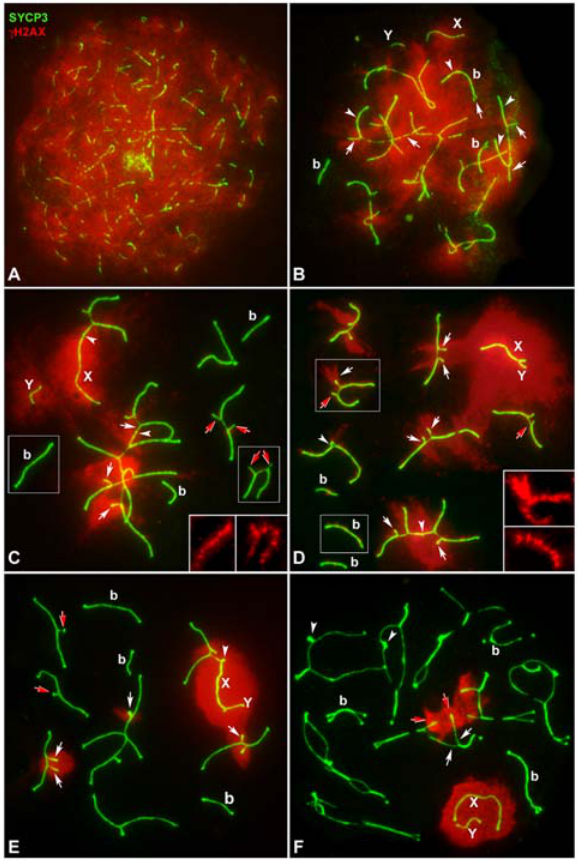
Figure 4. Localization of ATR (green) and SYCP3 (red) during prophase-I. (A) Early zygotene. ATR appears as foci localized in both the unsynapsed AEs (arrows) and the synapsed regions (arrowheads) of all chromosomes, excepting the Y chromosome. (B) Late zygotene. ATR foci are restricted to the AEs of unsynapsed chromosomes (white arrows). However, some unsynapsed AEs do not show ATR signal (red arrows). The Y chromosome (Y) shows a single ATR dot. (b) Bivalents. (C) Early pachytene. ATR appears as an irregular line running all along the unsynapsed AEs of open trivalents (white arrows) and the sex chromosomes (X, Y), although some open trivalents lack labeling (red arrows). Closed trivalents (arrowheads) do not show ATR labeling. (D) Mid-late pachytene. ATR localizes along the AEs of open trivalents (white arrows) and the sex chromosomes (X, Y) and becomes detectable in the surrounding chromatin. A trivalent shows a short unsynapsed AE without ATR signal (red arrow). (E) Late pachytene. ATR is detected along the unsynapsed AEs of trivalents and the sex chromosomes (X, Y) and is intensely distributed in the surrounding chromatin (arrows). (F) Early diplotene. Autosomes begin desynapsis. ATR localizes along the AEs and the surrounding chromatin of two trivalents (arrows) and the sex chromosomes (X, Y). One of the trivalents is ectopically associated with X chromosome (arrowhead). Newly desynapsed autosomes lack ATR labeling (red arrows). progressively faded and completely disappeared by the late diplotene stage. proteins: 1) monoubiquitinated H2A histone (ubiH2A) (Figure 5), known to be associated with transcriptional silencing of un- synapsed autosomes and sex chromosomes in mouse male meiosis [18]; 2) SUMO-1 (Figure 6), which is involved in SC assembly as